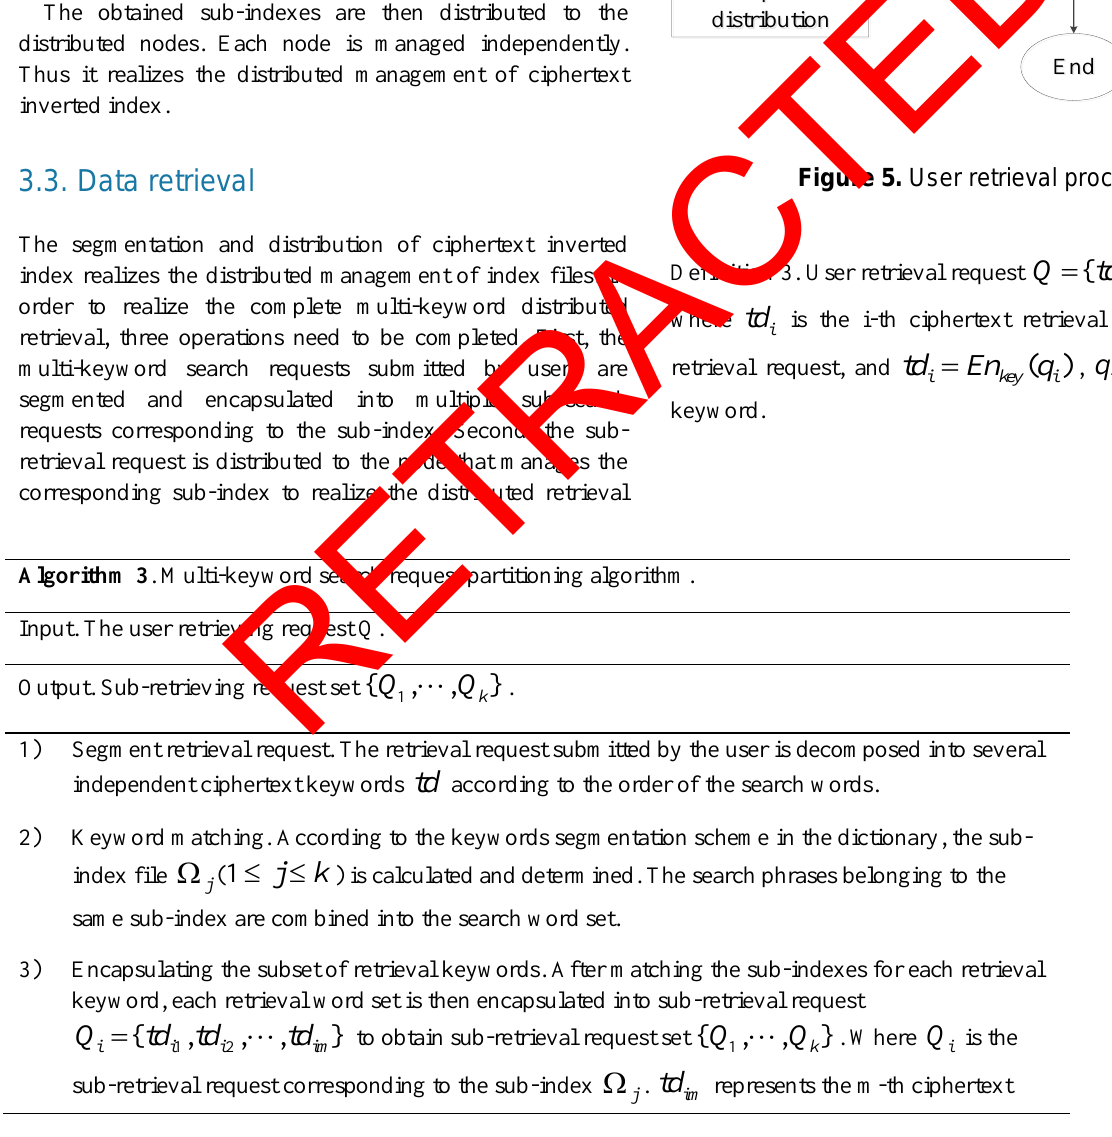
Figure 5. User retrieval process